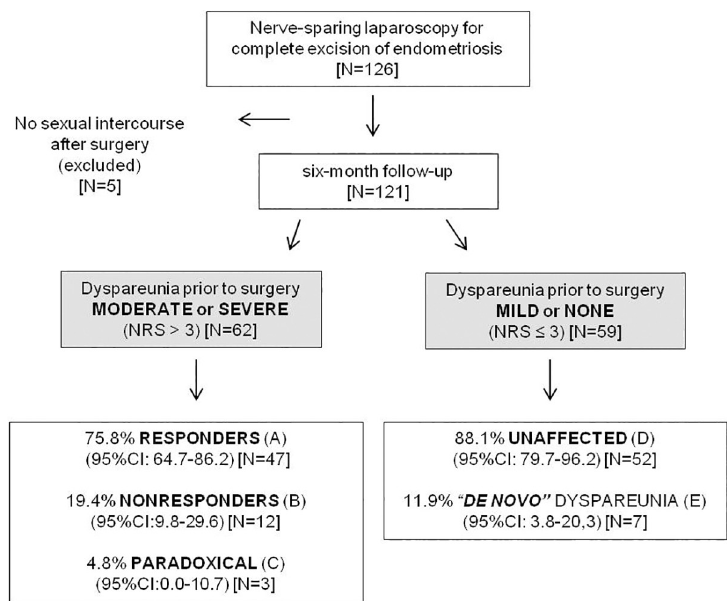
Fig 1. Response of deep dyspareunia intensity (primary outcome) to nerve-sparing laparoscopy. Deep dyspareunia was assessed on a self-reported 11-point numeric rating scale (NRS) on two occasions: prior to surgery (during the preoperative evaluation period) and at six-month follow-up. (A) NRS # by 3 points or more. (B) NRS changed by less than 3 points. (C) NRS " by 3 points or more. (D) NRS � 3 both before and after surgery [42 women reported no dyspareunia (NRS = 0) both before and after surgery 71.2% (95%CI: 59.4–82.8)]. (E) NRS prior to surgery = 0 and NRS " by 3 points or more. According to the scores, dyspareunia was hierarchically categorized as none/mild (0–3), moderate/tolerable (4–6), and severe/terrific dyspareunia (7–10).